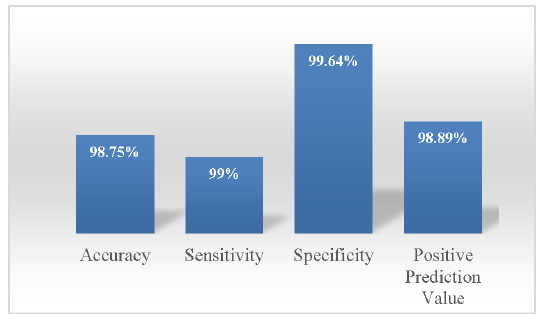
Figure 8: Performance Evaluation